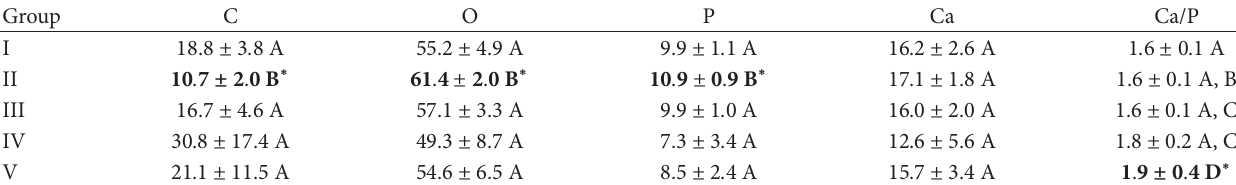
Table 2: Atomic percentages (at%) of C, O, P, and Ca and the Ca / P ratio in conditioned human primary enamel. Group C O